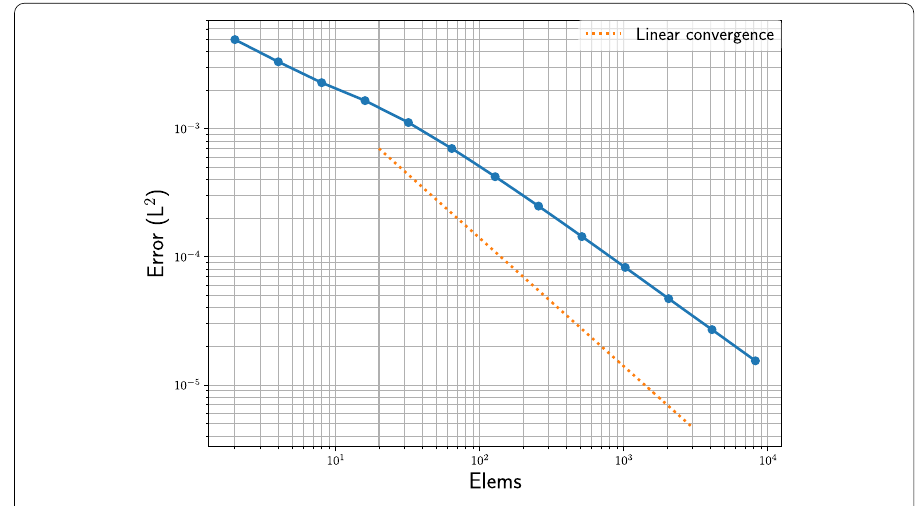
Fig. 6 L 2 -error for polynomial degree of 7 over increasing number of elements (h-refinement)